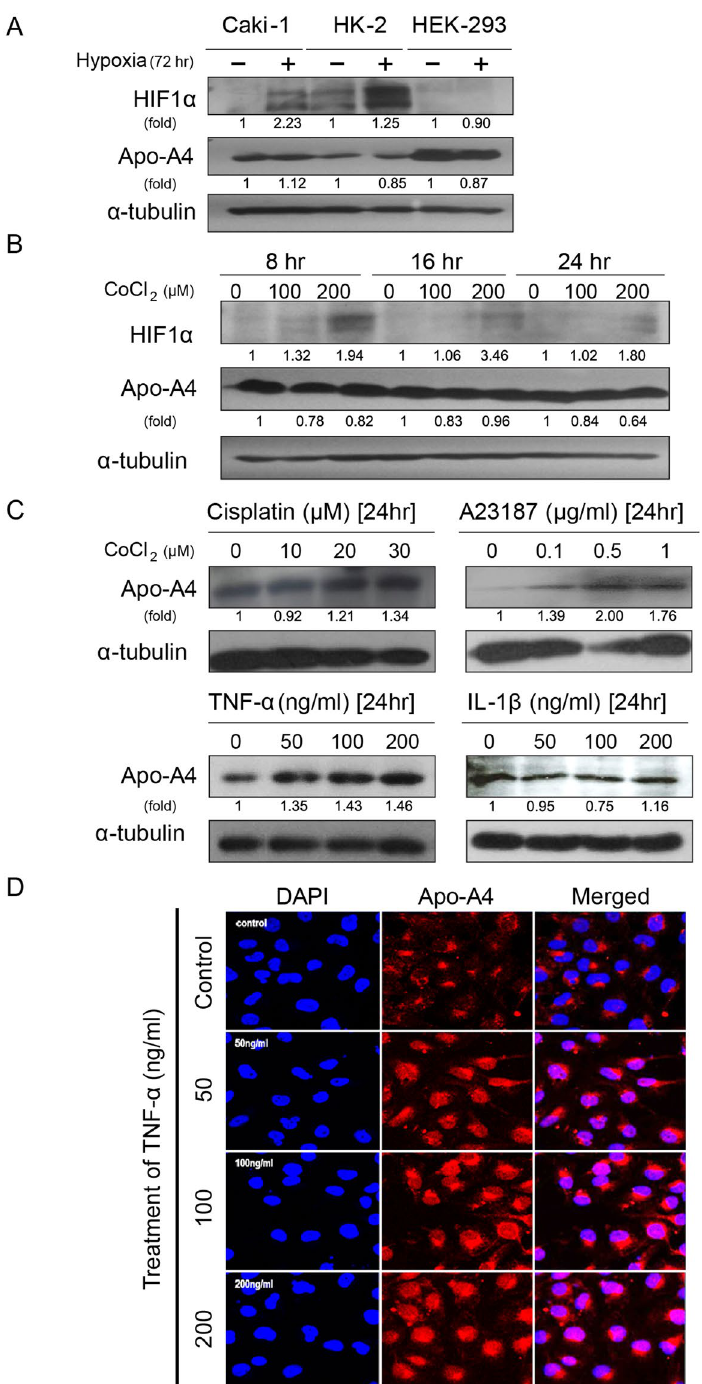
Figure 2. Effect of renal injury model expressed apo-A4 in kidney cell lines. ( A ) Hypoxic cell injury; HIF-1 α and apo-A4 expression in Caki-1, HK-2, and HEK-293 cells exposed to hypoxia for 72 h. ( B ) Chemical cell injury; HIF-1 α and apo-A4 expression in HK-2 cells treated with different concentrations of CoCl 2 (0, 100, and 200 µ M) for 8, 16, and 24 h. ( C ) Cytotoxic cell injury and cytokaine cell injury; Apo- A4 expression in HK-2 cells treated with cisplatin (0, 10, 20, and 30 µ M), A23187 (0, 0.1, 0.5, and 1 μ g/ ml), TNF- α (0, 50, 100, and 200 ng/ml), and IL-1 β (0, 50, 100, and 200 ng/ml) for 24 h (see Supplementary Figs S1, 2 and 3). ( D ) Immunofluorescence assay showing localization of apo-A4 (red) in HK-2 cells after 24 h of treatment with TNF- α